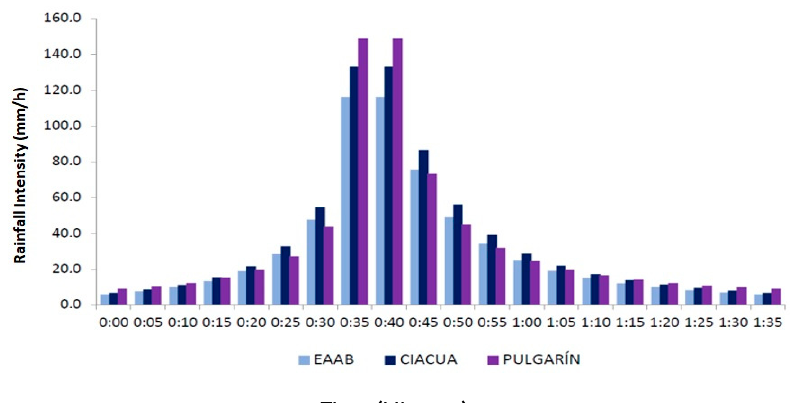
Figure 7. Synthetic hyetographs, considering three rainfall scenarios: Current rainfall scenario, Climate Change by Pulgarin equation, and Climate Change by CIACUA equation.